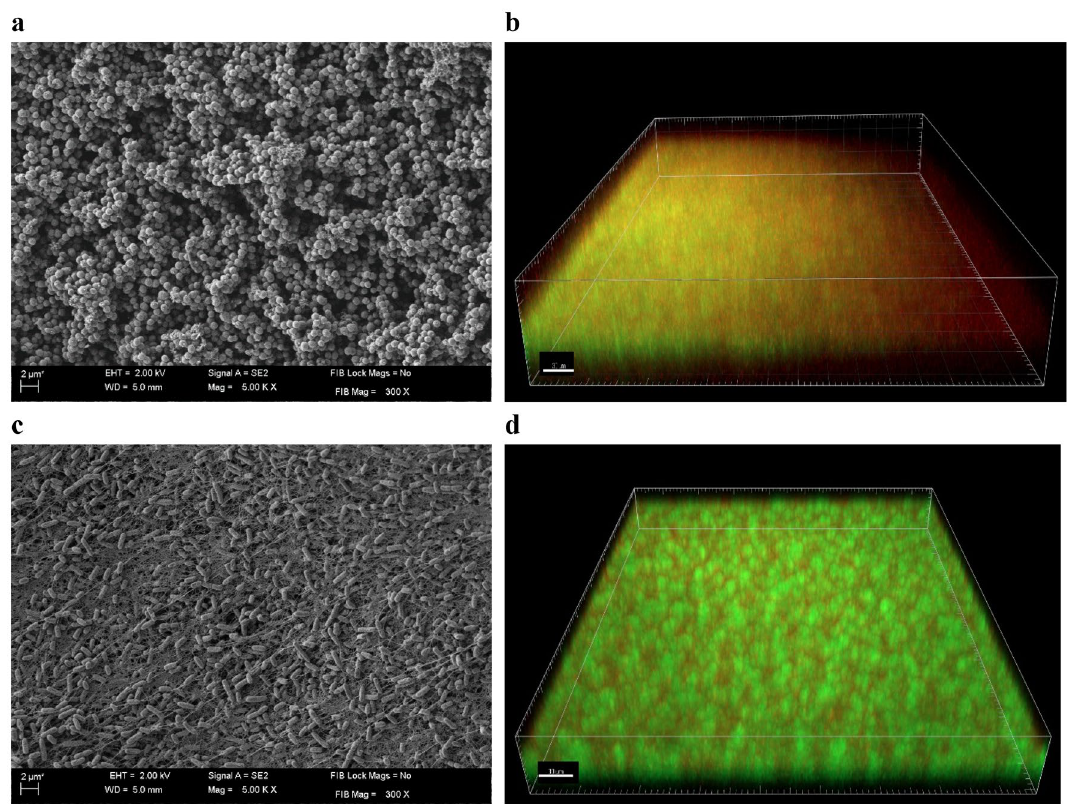
Figure 3. Structure of 48 h biofilm formed on agar discs visualized by scanning electron and confocal microscopy, ( a , b ) S. aureus and ( c , d ) P. aeruginosa . The magnification of pictures taken using SEM equals 5000× and confocal microscopy 40×.